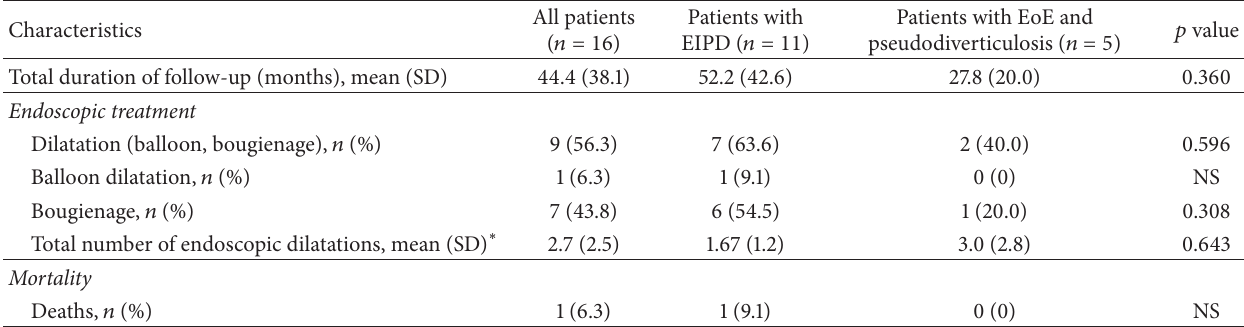
Table 2: The clinical course, therapeutic interventions, and outcomes for all patients, including subgroup analysis of patients with EIPD and with EoE and